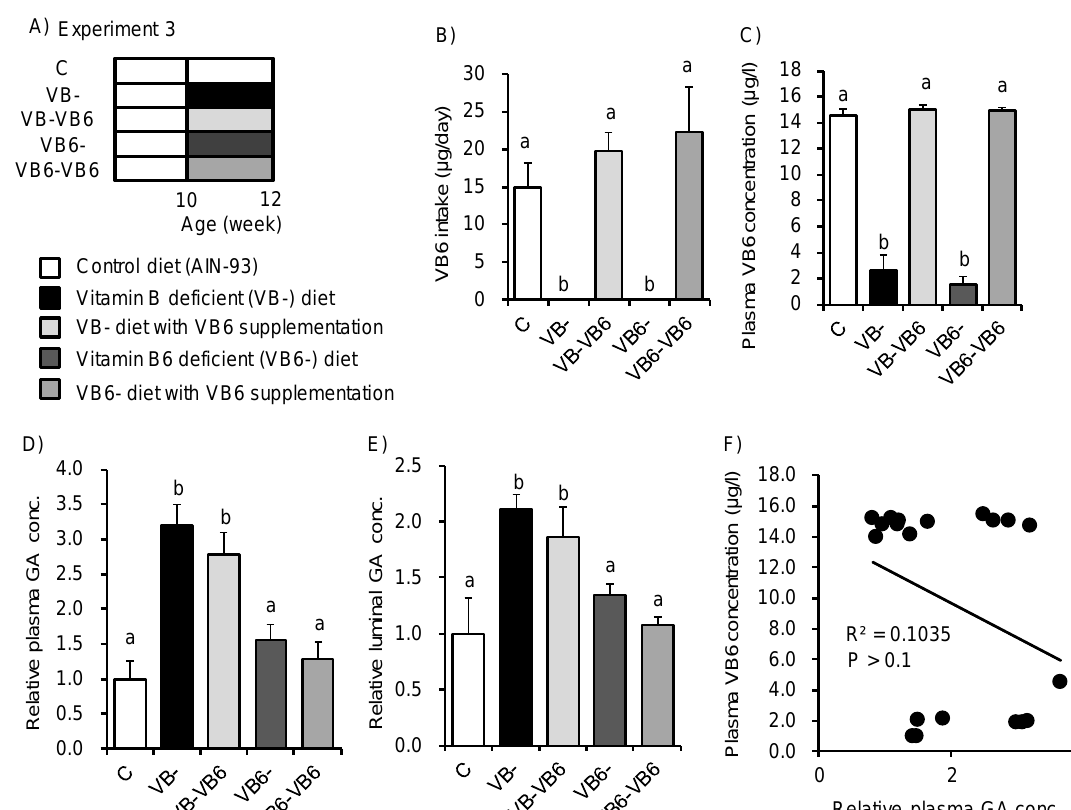
Figure 3. Feeding of a vitamin B 6 -deficient diet did not induce glycolate accumulation in plasma or luminal content. ( A ) Study design for Experiment 3. Mice were fed the control diet, VB- diet, or vitamin B 6 -deficient (VB6-) diet for 2 weeks with or without VB6 supplementation (6 μg/mL pyridoxine hydrochloride solution in distilled water). ( B ) Average daily VB6 intake and ( C ) plasma VB6 concentration for the five groups. ( D , E ) Relative concentration of GA in ( D ) plasma and ( E ) luminal content for the five groups. ( F ) Spearman’s rank correlation coefficients between plasma VB6 concentration and plasma GA levels (R 2 = 0.1035, p > 0.1). ANOVA was used to determine the differences in each group ( n = 4). Different letters indicate p < 0.05.